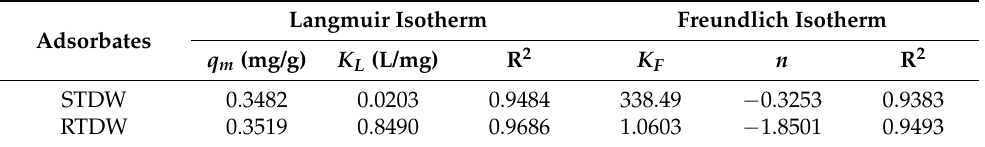
Table 4. Langmuir and Freundlich isotherm constants for adsorption of STDW and RTDW. (Exper- imental conditions: C o STDW = 100 mg/L; C o RTDW = 10.0 mg/L; absorbent dosage = 1.0 g per